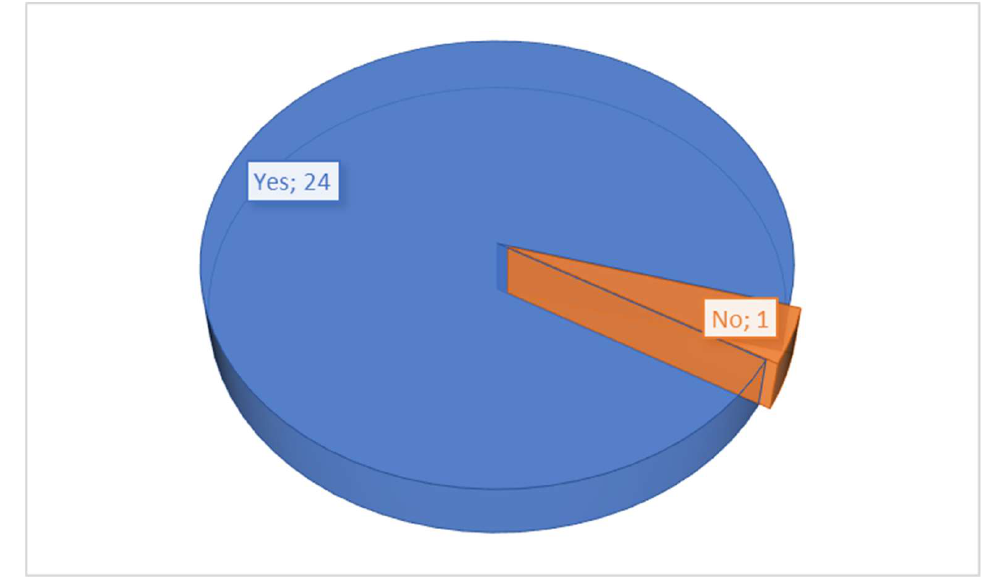
Figure 13. Willingness to engage in open innovations of the competition. An essential aspect in sharing data is the operator’s actual approach to sharing its own data with other users in this competition. The results of the research indicate that only 28% of respondents would not see a problem with sharing data about their company. Specific results are presented in Figure 14.